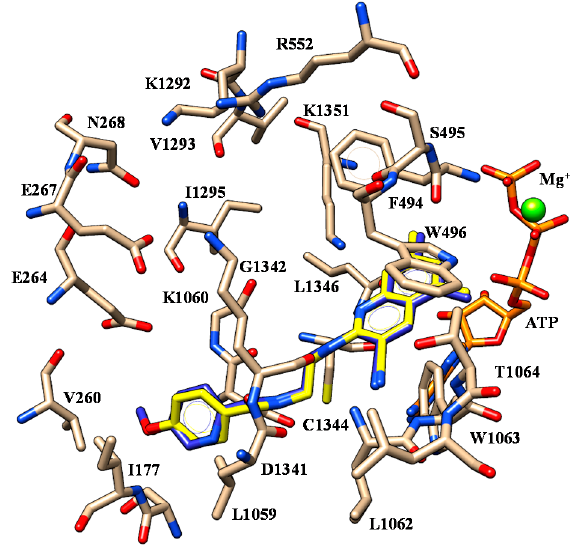
Figure 15. Selected docking mode of 59 (C atom; yellow) and 67 (C atom; blue) within the modelled F508del-CFTR. The most important residues are labelled.